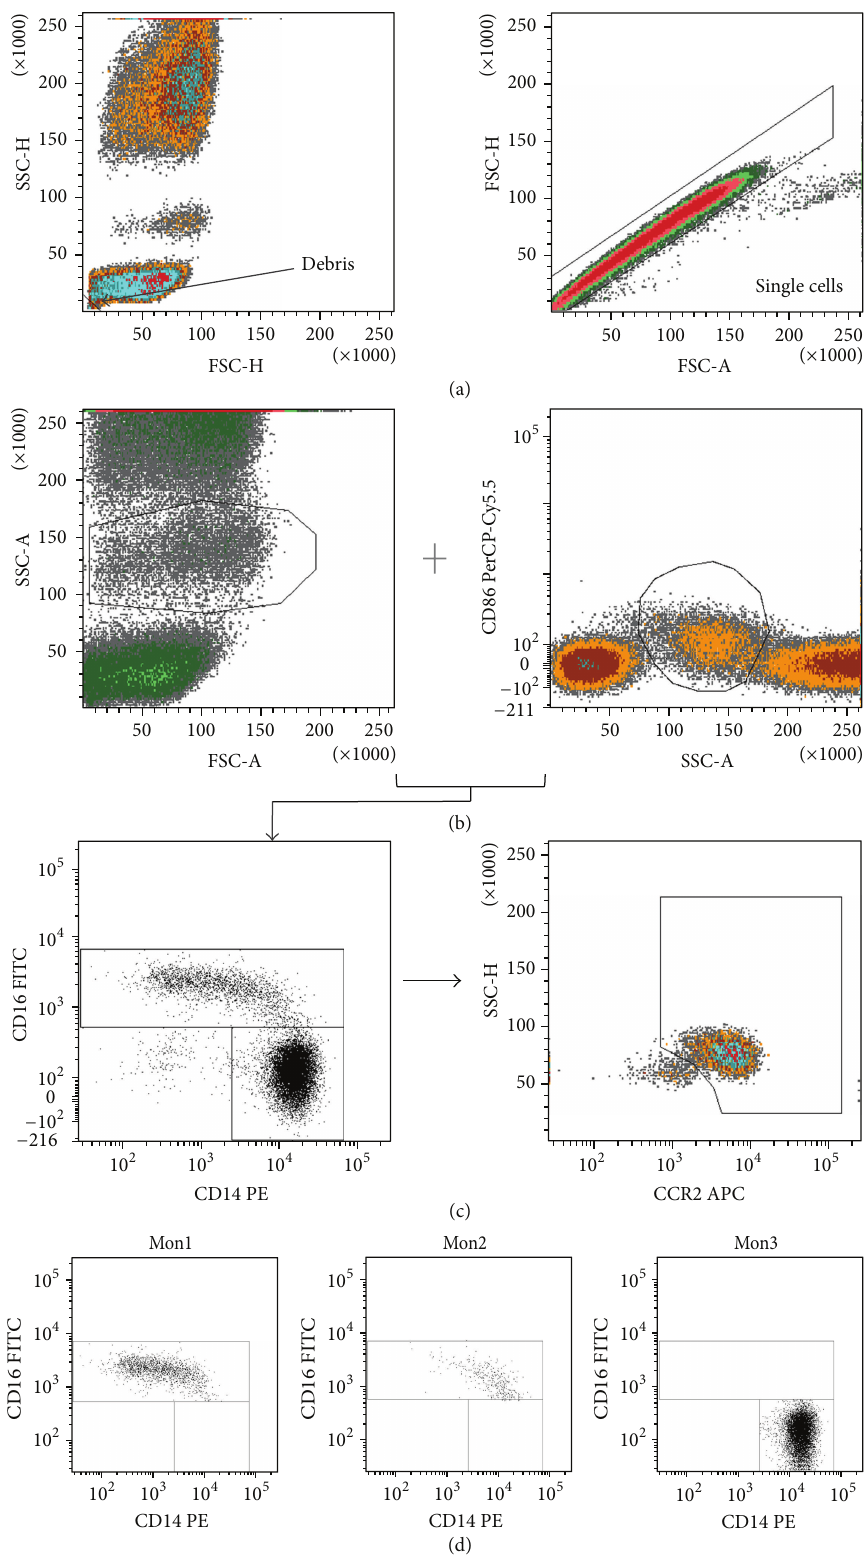
Figure 1: Gating strategy. Gating strategy and presentation of monocyte subsets. (a) Exclusion of debris and doublets. (b) Identification of monocytes based on the forward scatter (FSC) versus side scatter (SSC) plot and CD86 positivity. (c) Separation of monocytes in CD16 positive and CD16 negative monocytes and subsequent distinction between Mon2 and Mon3, based on CCR2 expression. The plot shows all monocyte subsets, with Mon1 as per definition in the CCR2 + gate. (d) Respective location of the monocyte subsets on CD14 versus CD16